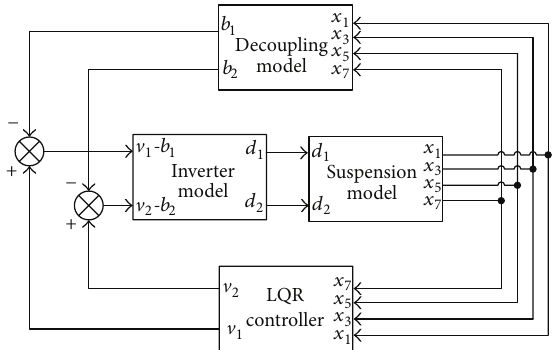
Figure 2: Control model of semiactive connected hydropneumatic